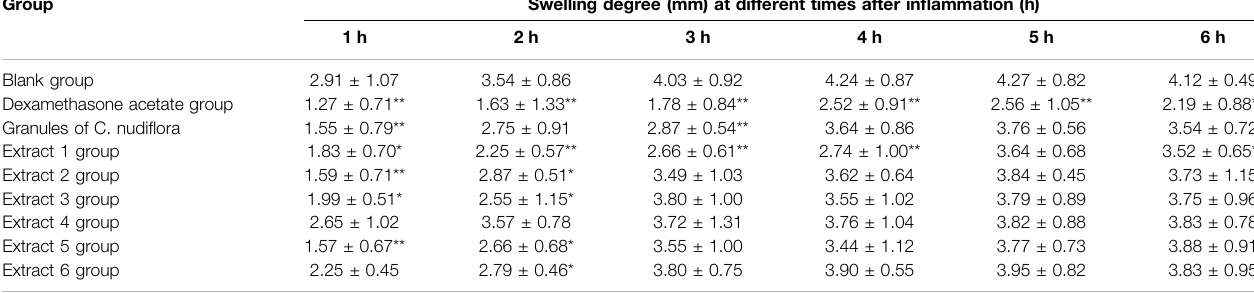
TABLE 1 | Effect of different C. nudi fl ora extracts on carrageenan-induced swelling of rats ( (cid:1) X ± s ).